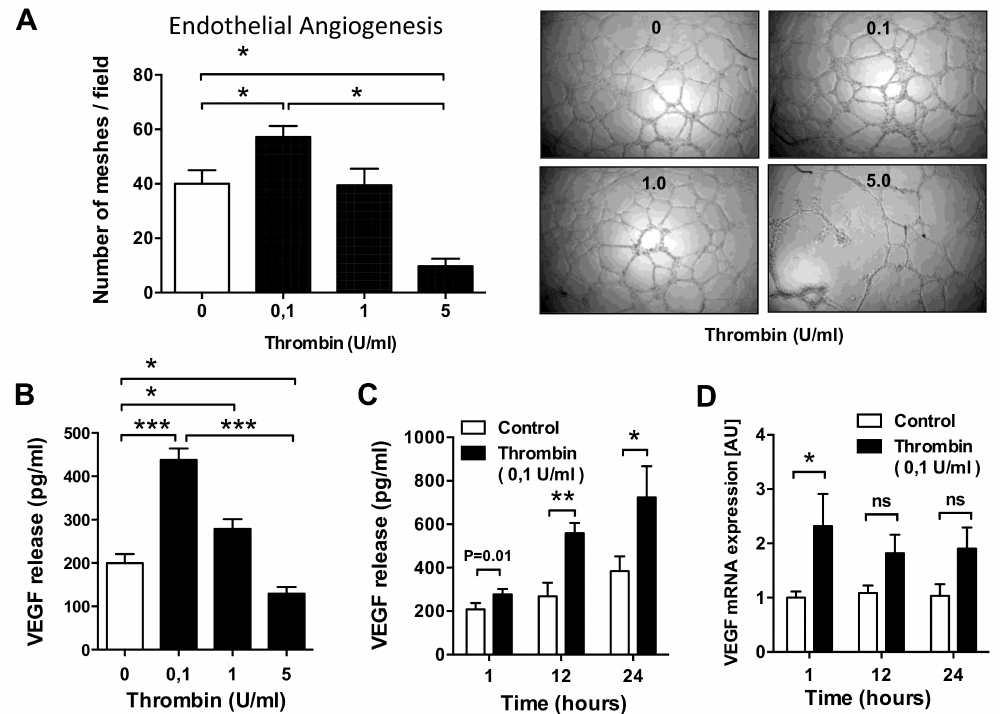
Figure 2. Effect of thrombin on microvascular EC angiogenesis and VEGF production. ( A ) Human microvascular endothelial cells (HMECs) were stimulated with thrombin at the indicated doses (0.1, 1.0, and 5.0 U/mL), and EC tube formation was assessed after 16 h, with data expressed as the average number of meshes per field ( n = 4) and representative figures shown to the right. ( B – D ) HMECs were cultured in the presence or absence of thrombin ( n = 8) and assessed for dose- (0.1, 1.0, and 5.0 U/mL) and time-dependent (6, 12, and 24 h) VEGF secretion ( B , C ) and VEGF mRNA levels ( C ). The exposure time in ( A ) was 24 h, while the dose of thrombin in ( C , D ) was 0.1 U/mL. ANOVA mean +/ − SEM with * p < 0.05, ** p < 0.01, and *** p <